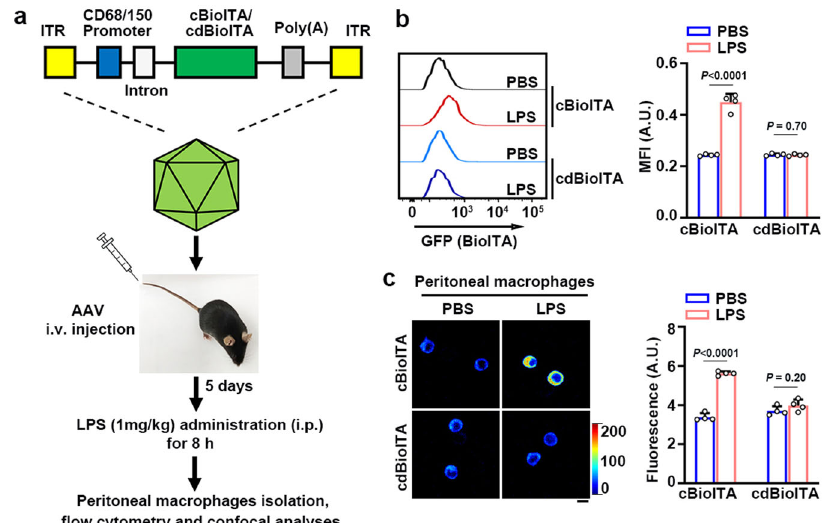
Fig. 6 | BioITA detects itaconate in activated macrophages derived from LPS- injected mice. a – c Schematic illustration of intravenous injection of AAV (1×10 11 viral genomes in 100 μ l PBS) encoding cBioITA or the control biosensor cdBioITA under the control of a macrophage ‐ speci fi c promoter CD68/150 into 6-week-old female C57BL/6J mice ( n =4). The mice were intraperitoneally injected without or with LPS (1mgkg − 1 ) on day 5 post AAV injection and peritoneal macrophages were isolated 8h after LPS injection. P values were determined by the two-tailed Stu- dent ’ s t -test. ITR inverted terminal repeat, cBioITA cytosolic BioITA, cdBioITA